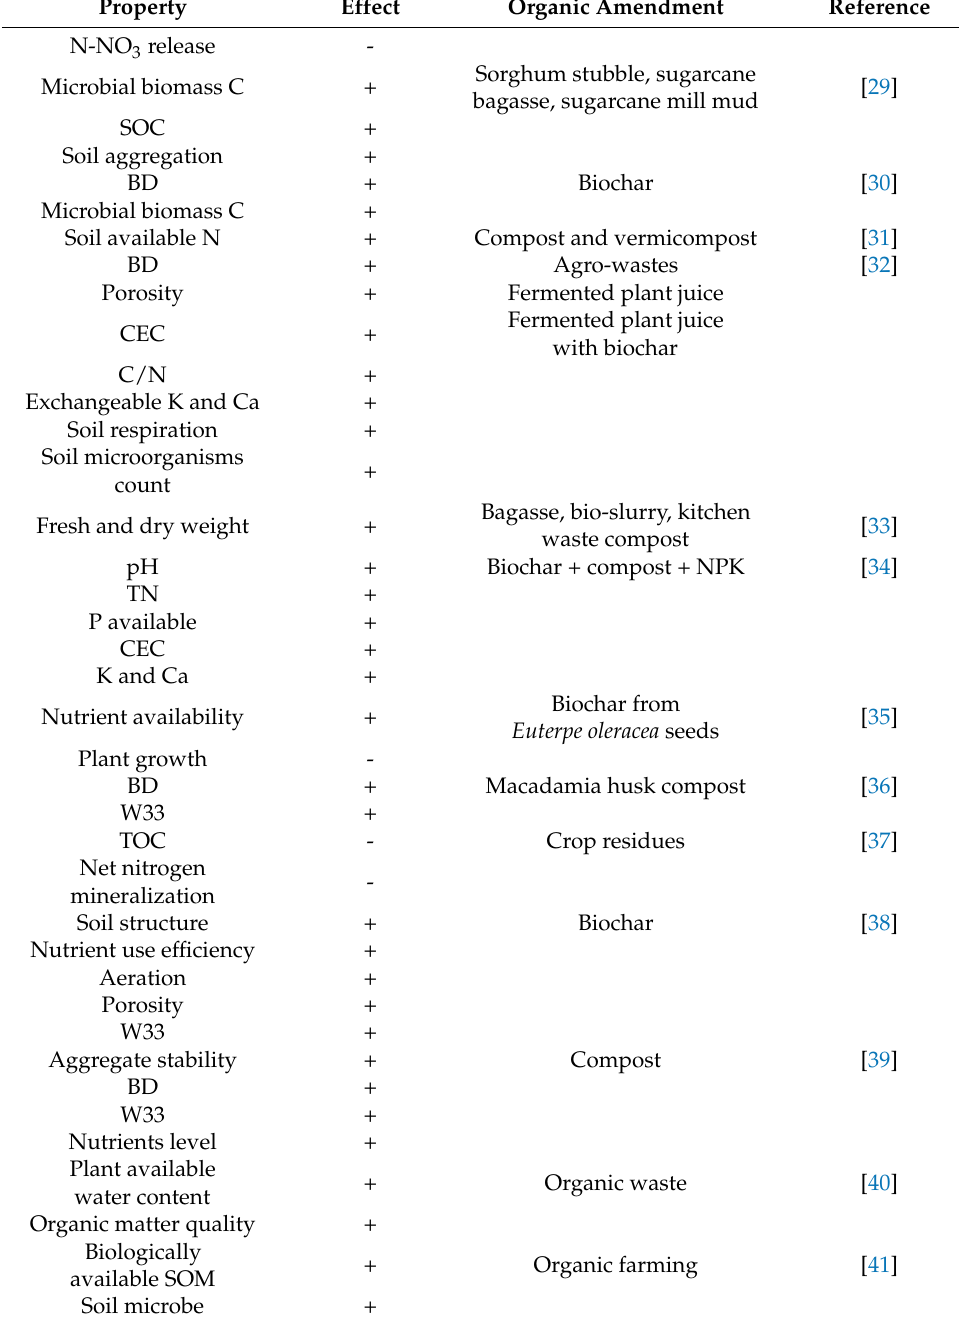
Table 1. Cont. Property Effect Organic Amendment